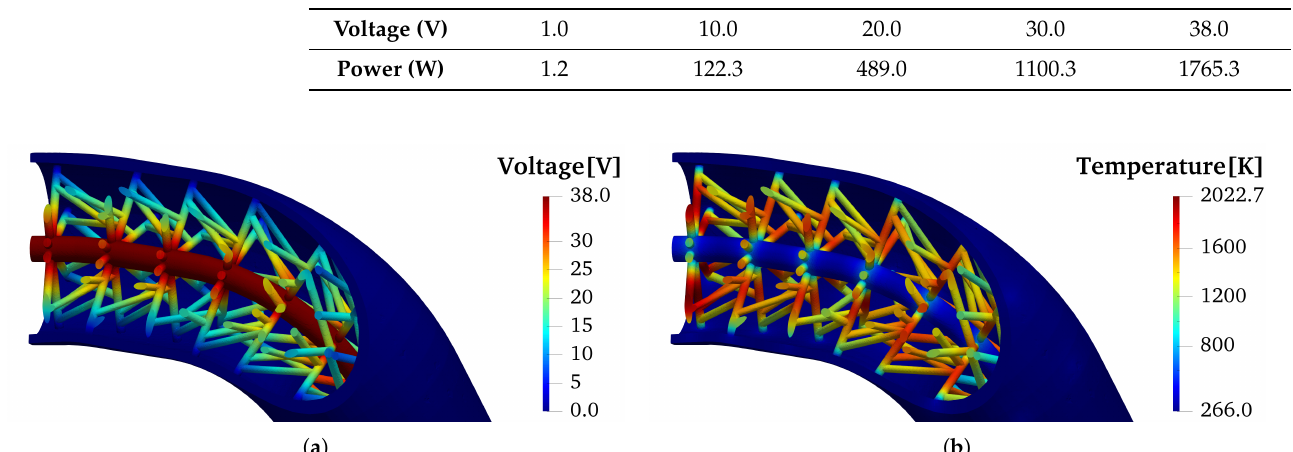
Table 7. Electrical heating sensitivity analysis: supplied electrical power.